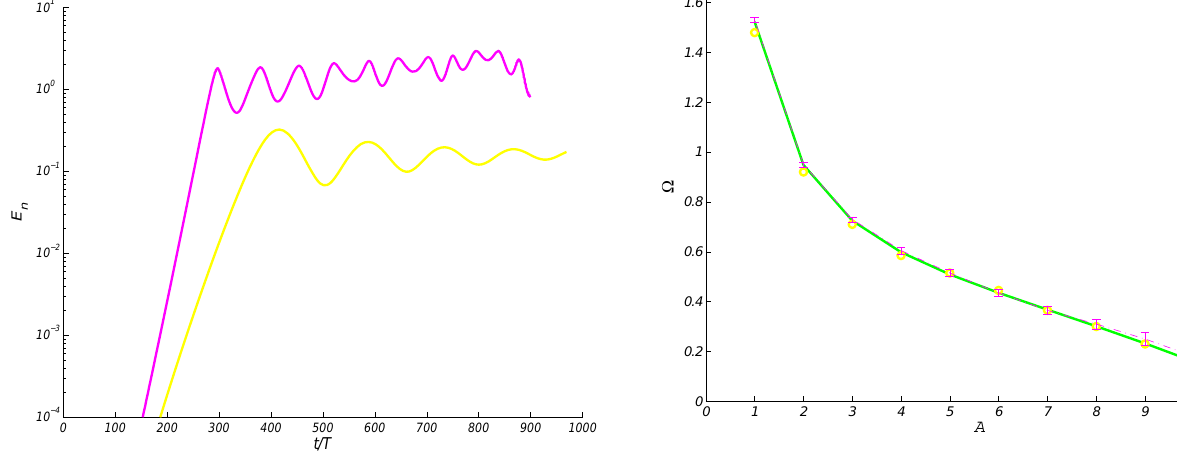
Fig. 5. Time evolution of the norm E n for ( A ,(cid:127)) = ( 4 , 0 . 59 ) ( — ) and ( A ,(cid:127)) = ( 4 , 0 . 61 ) ( — ).